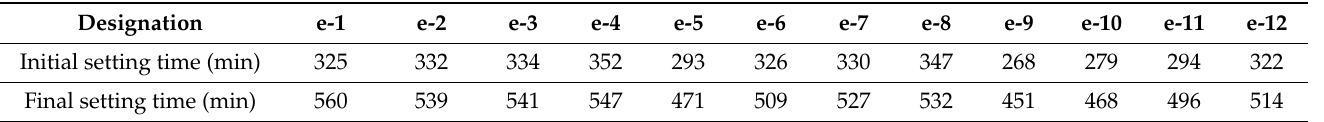
Figure 3. The density of grout consolidation. Table 5. Test results of setting